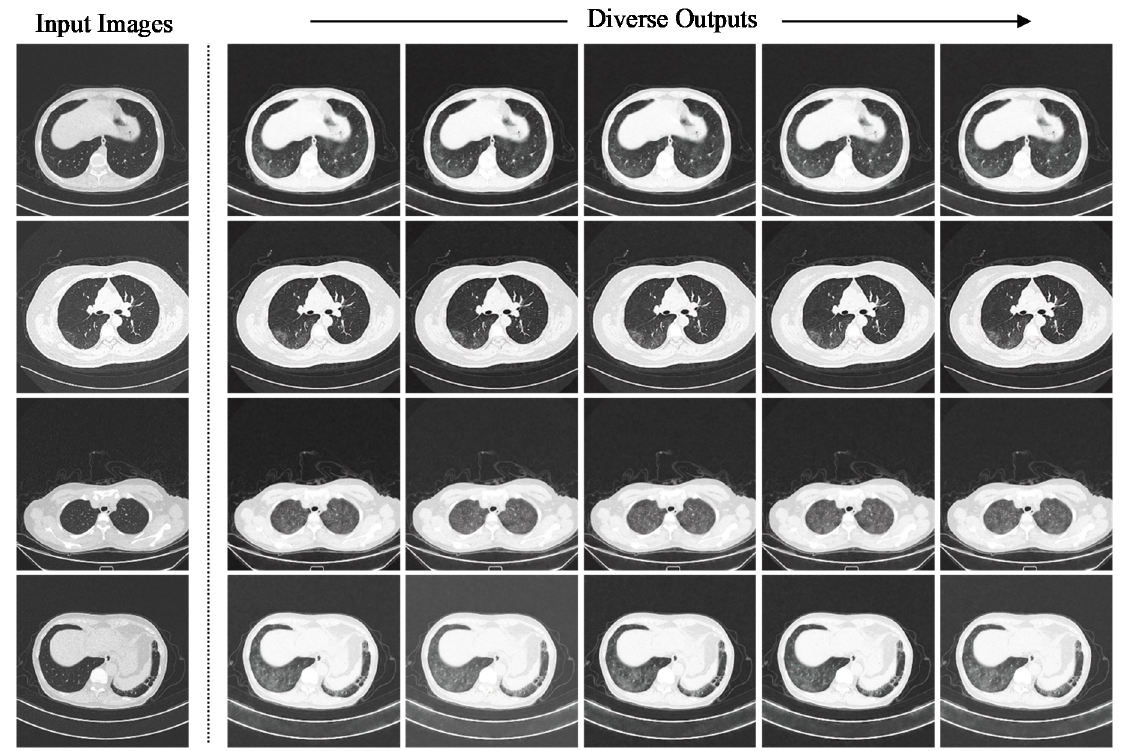
Figure 20. Examples of instance-diverse CAP CT images generated from sRD-GAN.